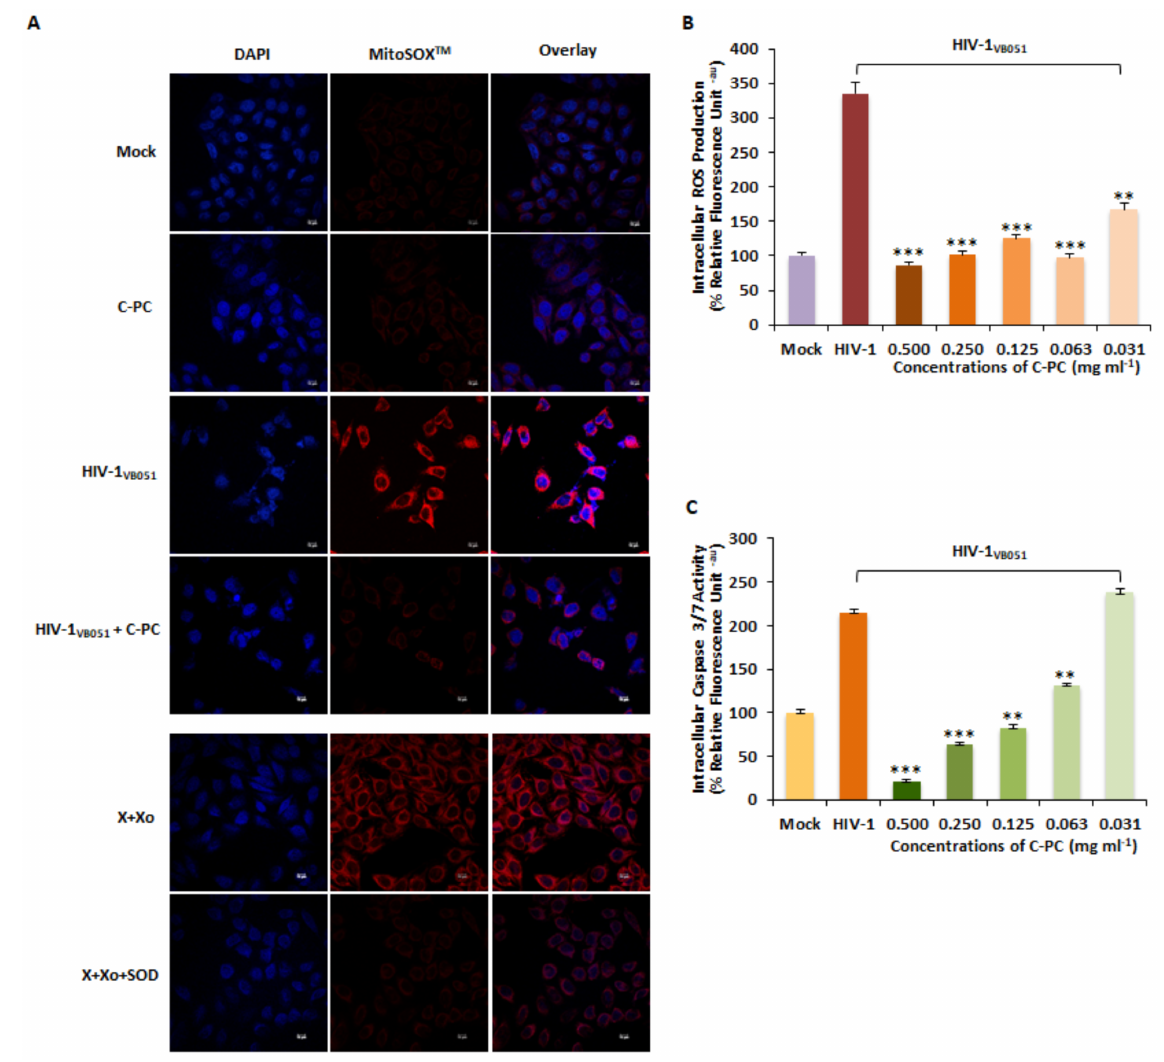
Figure 7. ROS Scavenging effects of C-PC in HIV-1-infected cells. ( A ) MitoSOX TM Red Probe staining and ROS Scavenging effects of C-PC (0.1740 mg/mL–IC50 value) in HIV-1 VB051 -infected TZM-bl cells at 24 hpi. Mitochondria superoxide (red) and nuclear DNA (blue) showed under laser confocal microscope at standard magnification (63X 1.4 NA oil objective). The scale bar of the figure indicates a size of 50 µ m. ( B ) Fluorescence measurement (arbitrary units, AU) was used to determine the ROS scavenging effects. Results are displayed as bar graphs that illustrate the proportion of fluorescence- positive cells labeled with MitoSOX TM after 24 hpi. ( C ) Effect of C-PC on Caspases activation in HIV-1-infected TZM-bl cells. The figure represents the dose-dependent activity of caspase3/7 at 24 hpi. The data shown are the representative of at least three independent experiments. ** p < 0.01 and *** p <